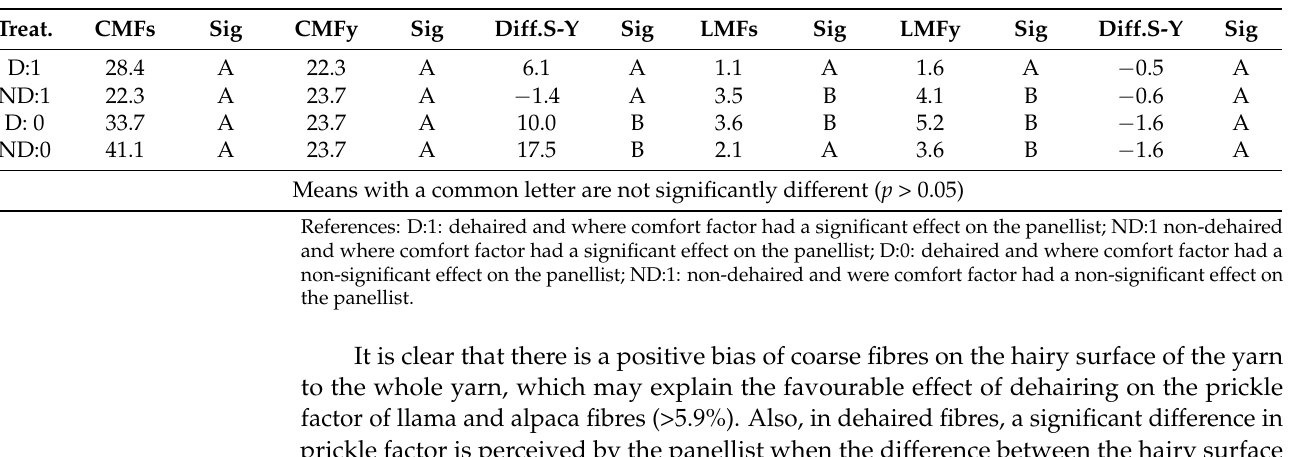
Table 3. The mean comparison of the continuous medulla (CMF) content (s: surface; y: yarn), the lattice medulla (LMF) content (s; y), and the difference between the surface and the yarn (Diff.S-Y), in relation to the interaction of dehairing (D; ND) per perception effects (0: non-sig.; 1: sig.).